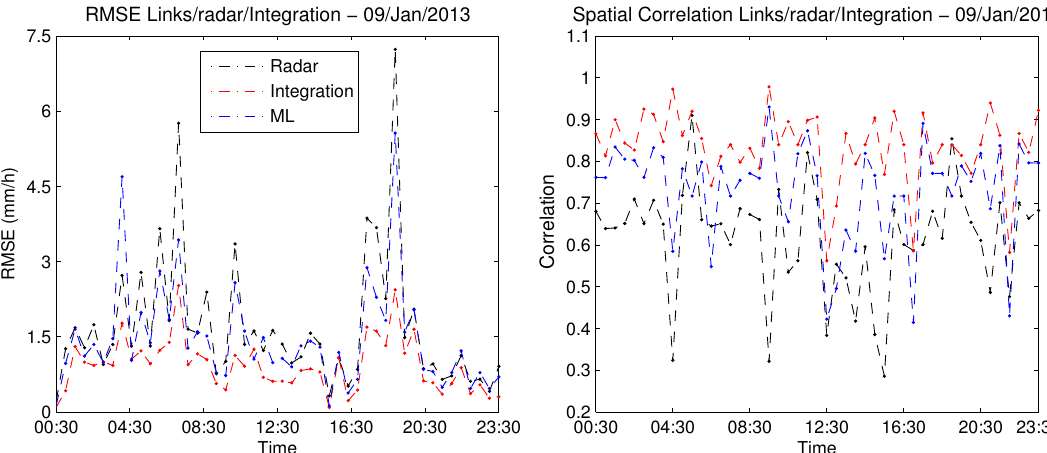
Figure 8. Evaluation analysis of event 2, where the radar (black line), the proposed integration technique (red line) and ML (blue line) are compared to the rain gauges at the common times. Left: RMSE. Right: spatial correlation.